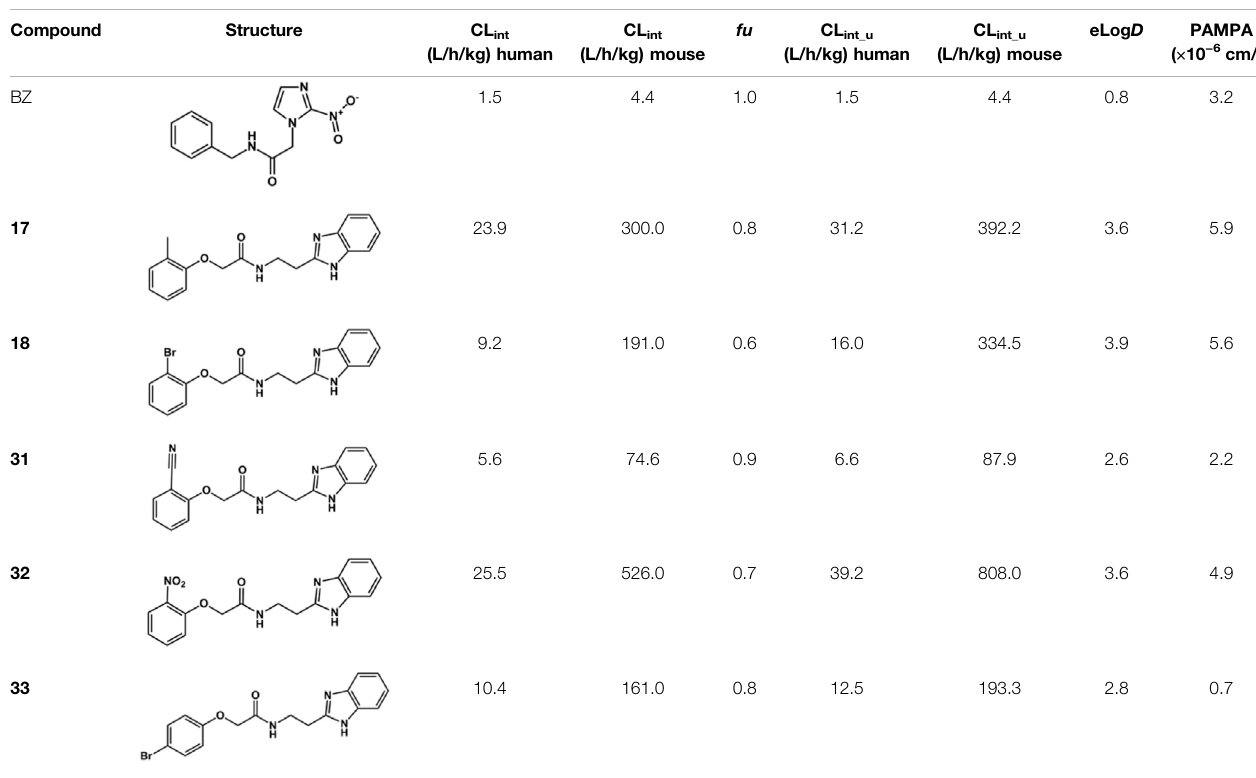
TABLE 5 | In vitro PK pro fi le of benzimidazole analogs. Compound